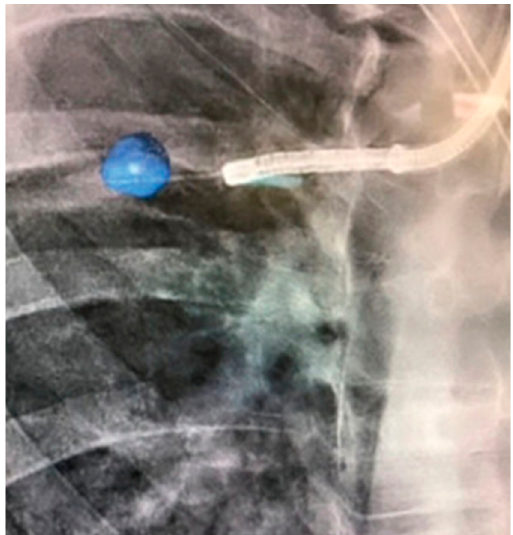
Figure 6. CBCT (Philips Healthcare) imaging during Monarch ® Robotic Bronchoscopy with real-time location of the lesion in blue. Reprinted with permission from AME publishing company [21].